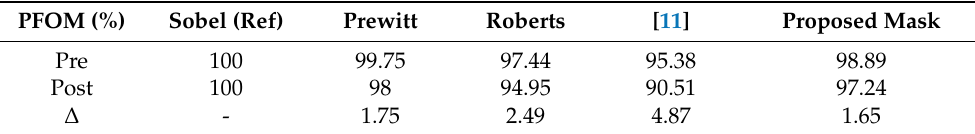
Table 4. Pratt’s figure of merit (PFOM) of results from five different edge masks.